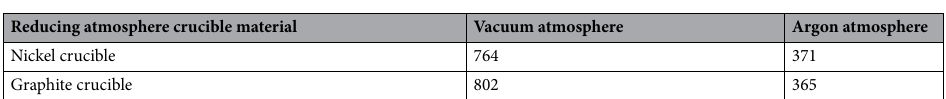
Reducing atmosphere crucible material Vacuum atmosphere Argon atmosphere Nickel crucible 764 371 Graphite crucible 802 Table 1. Oxygen content (PPM) of acid washed niobium powder reduced by different reduction atmospheres and crucibles.